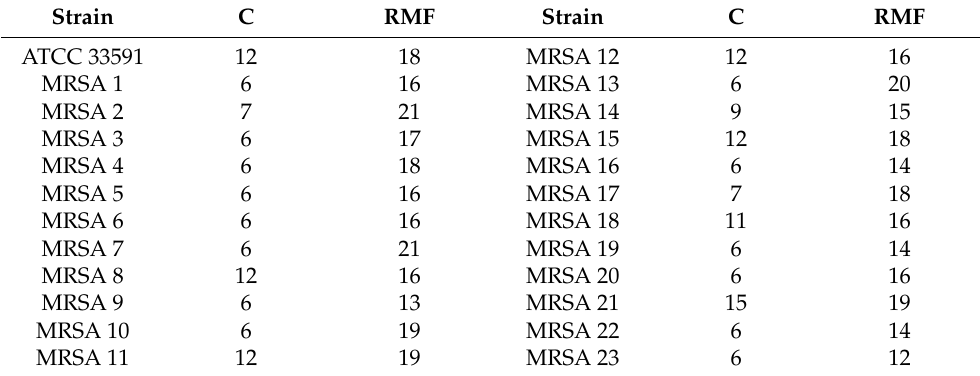
Table 5. Zones of growth inhibition (mm) of MRSA strains around cefoxitin discs in control and RMF-exposed (5 Hz) cultures.